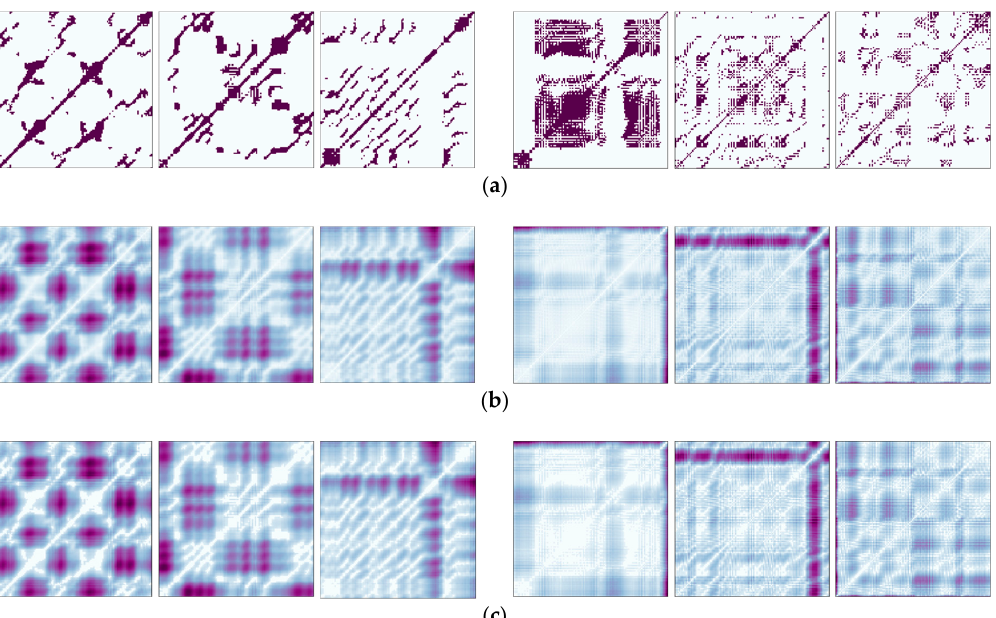
Figure 5. Three types of RPs produced from ECG signals (shown in Figure 4) at drowsy ( left ) and awake ( right ) states: ( a ) Bin-RP; ( b ) Cont-RP; ( c ) ReLU-RP.